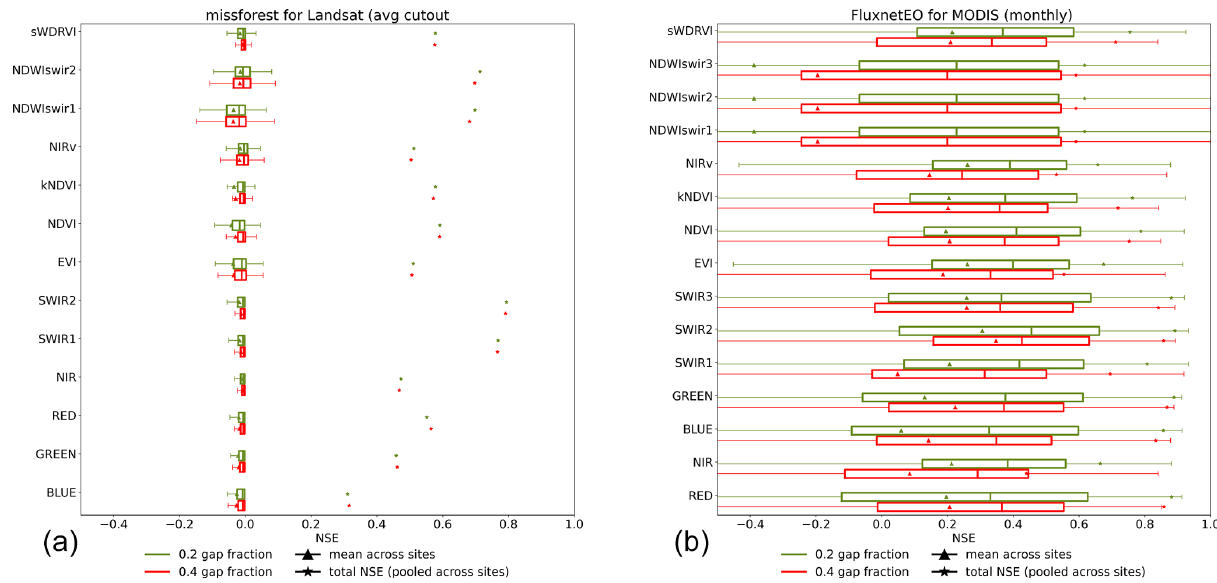
Figure C2. Benchmarking in artificial gaps: distribution of NSE per site of the gap-fill estimates in artificial gaps by FluxnetEO. A total of 20% and 40% of data were removed and gap-filled. (a) Landsat time series of the average reflectance/vegetation index across the whole cutout. (b) The centre pixel of MODIS data aggregated to monthly temporal resolution.